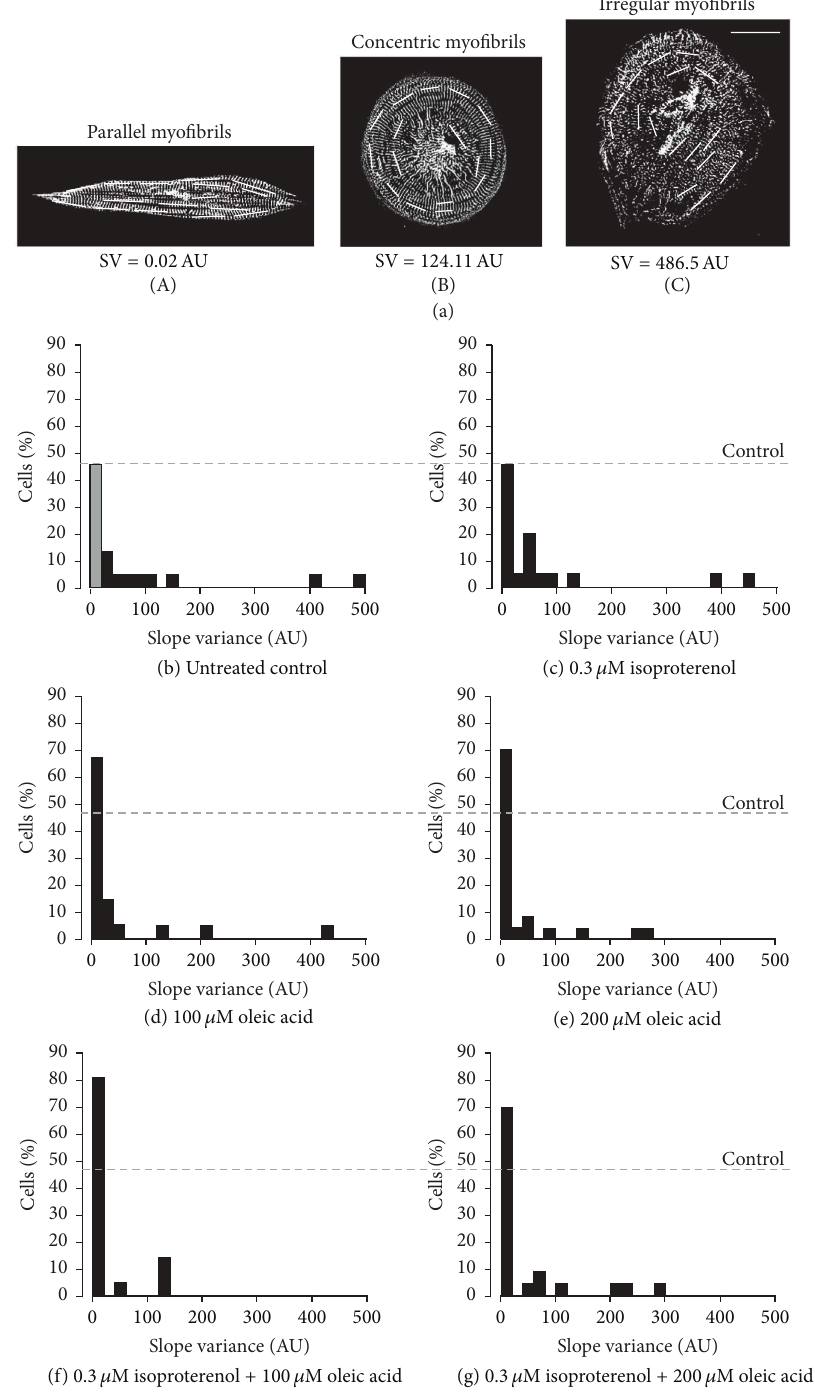
Figure 3: Effect of isoproterenol and oleic acid on the orientation of myofibrils in the hESC-vCMs. ((a) panel (A)–(a) panel (C)) The orientation of the myofibrils localized within hESC-vCMs was determined by calculating the slope of lines placed along the length of the myofibrils. ((a) panel (A)) hESC-vCMs with the myofibrils arranged in parallel exhibited a low slope variance (SV) value (e.g., 0.02 AU), when compared with ((a) panel (B)) cells where the myofibrils were arranged in a concentric manner and exhibit an SV of ∼ 124 AU or ((a) panel (C)) where the myofibrils were arranged in an irregular orientation when the SV was greater again (e.g., ∼ 480AU). Scale bar is 30 𝜇 m. (b–g) Histograms to show the distribution of cells (in %) exhibiting a particular variance value in (b) untreated controls and (c–g) following treatment with (c) 0.3 𝜇 M isoproterenol, (d) 100 𝜇 M oleic acid, (e) 200 𝜇 M oleic acid, (f) 0.3 𝜇 M isoproterenol plus 100 𝜇 M oleic acid, or (g) 0.3 𝜇 M isoproterenol plus 200 𝜇 M oleic acid. 𝑁 = 20 for each treatment group and the untreated controls. The grey bar and grey dashed lines indicate the percentage of cells in the untreated control group with the lowest myofibrillar SV